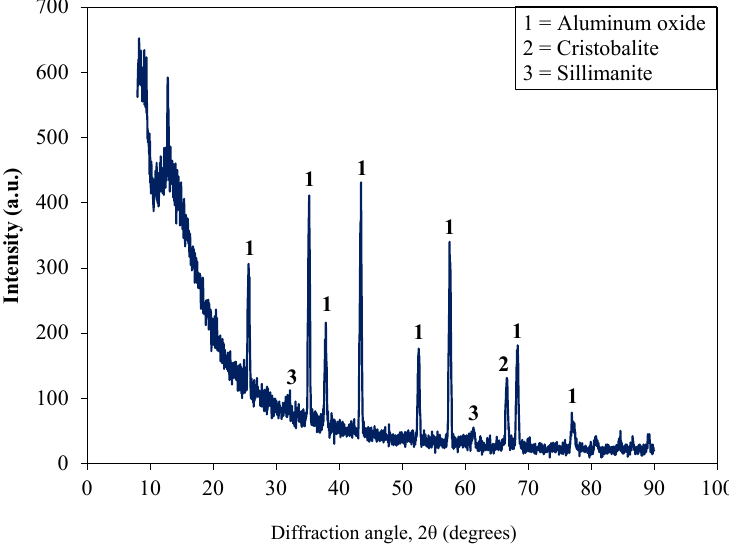
Figure 2. XRD analysis of used waste alumina powder. A high-performance concrete pan mixer was used for mixing purposes. All materials were placed in the pan of a concrete mixer in layers starting with fine aggregates, AP, NF, cement and coarse aggregates. These materials were dry mixed for one minute at 150 rpm. Afterwards, about 75% of the mixing water was added and the mixing was continued